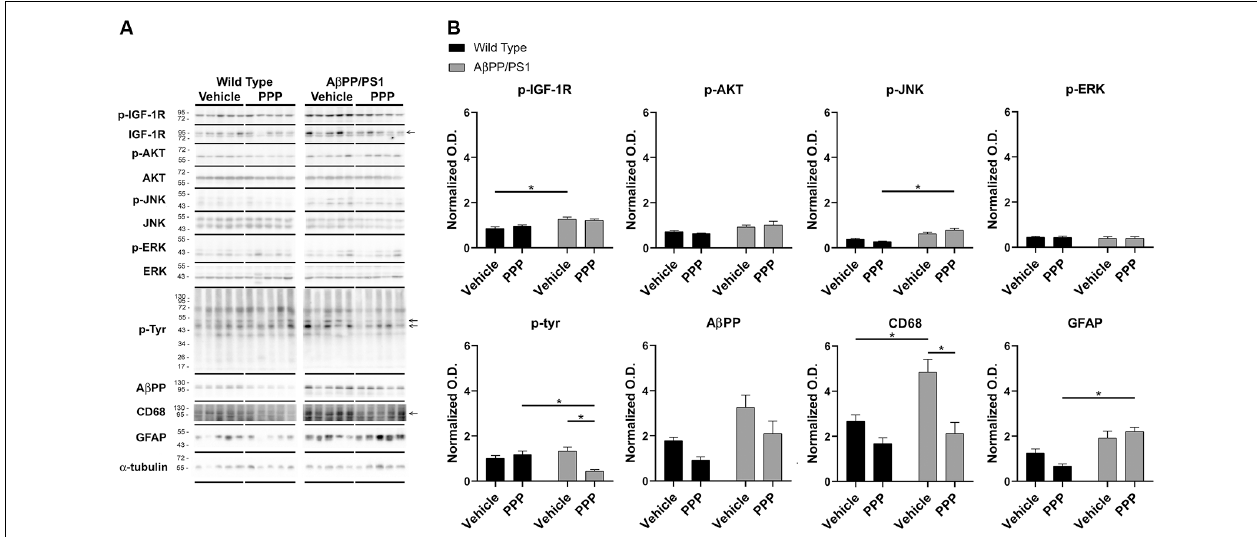
FIGURE 3 | p-tyrosine and CD68 levels were attenuated by inhibitor treatment in A β PP/PS1 mice. Hippocampal lysates from vehicle and PPP (1 mg/kg, 7 days) treated WT and A β PP/PS1 mice were (A) western blotted to (B) quantify protein changes related to IGF-1R signaling, microgliosis, and A β PP levels. p-IGF-1R, p-AKT, p-JNK, and p-ERK blots were normalized to their respective IGF-1R, AKT, JNK, and ERK loading controls. The p-tyrosine, A β PP, CD68, and GFAP blots were normalized to their respective α -tubulin loading controls. Data are mean O.D. ± SEM, * p < 0.05 ( n = 5 animals). Two-way ANOVA indicate p-IGF-1R F (1,16) = 1.047 and p (interaction) = 0.3215; p-Akt F (1,16) = 0.8088 and p (interaction) = 0.3818; p-JNK F (1,16) = 4.291 and p (interaction) = 0.0548; p-ERK F (1,16) = 0.008505 and p (interaction) = 0.9277; p-Tyr F (1,15) = 13.98 and p (interaction) = 0.0020; A β PP F (1,15) = 0.1227 and p (interaction) = 0.7310; CD68 F (1,15) = 3.929 and p (interaction) = 0.0661; GFAP F (1,16) = 4.429 and p (interaction) = 0.0515. The errors from comparisons of several pairs of means in the experiment were adjusted using Tukey’s multiple comparison